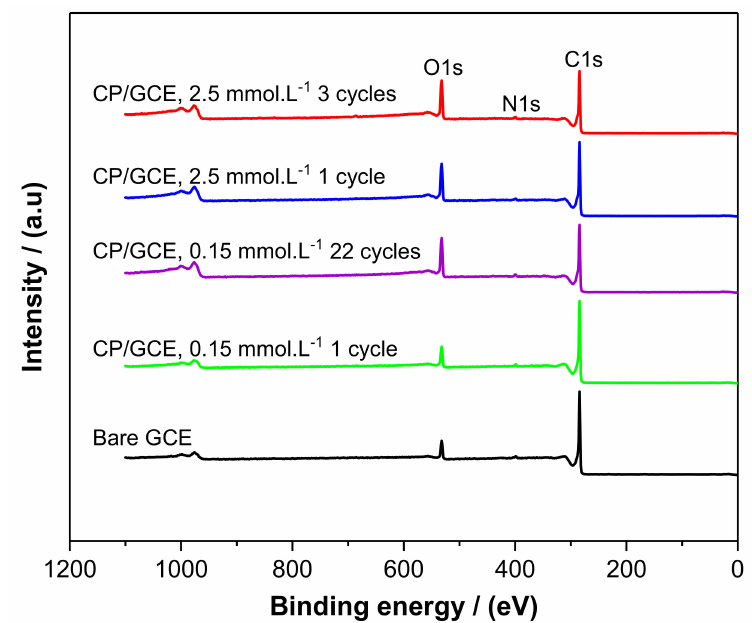
Figure 3. Survey spectra of bare GCE (black), grafted GCE (CP / GCE) using 0.15 mmol / L 4-CBD: for 1 cycle (green) and 22 cycles (violet), and grafted GC (CP / GCE) using 2.50 mmol / L 4-CBD: for 1 cycle (blue) and 3 cycles (red).